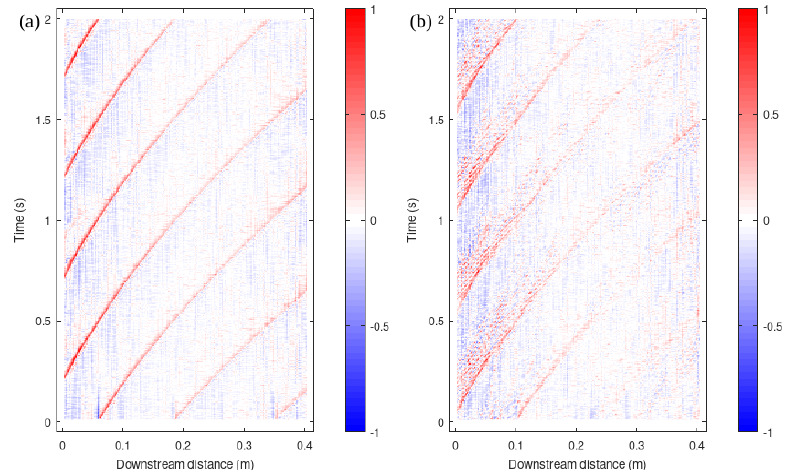
Figure 3. False-colour maps showing the spatiotemporal traces of solitary-like waves forced at the frequency of 2Hz. ( a ) No vibration. ( b ) The inclined plate is vibrated with the frequency of 48Hz and the peak vibration amplitude of 1 g.